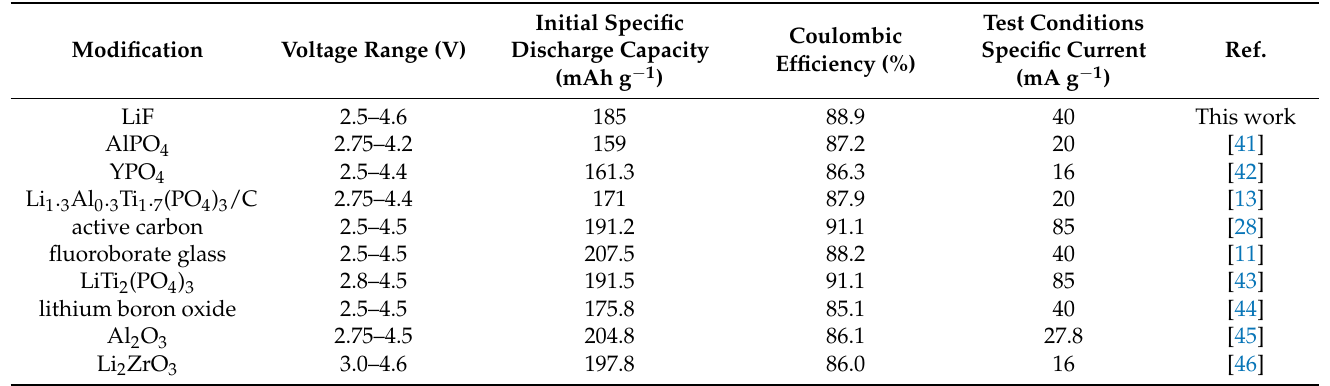
Table 1. The performances of our work compared to some previous